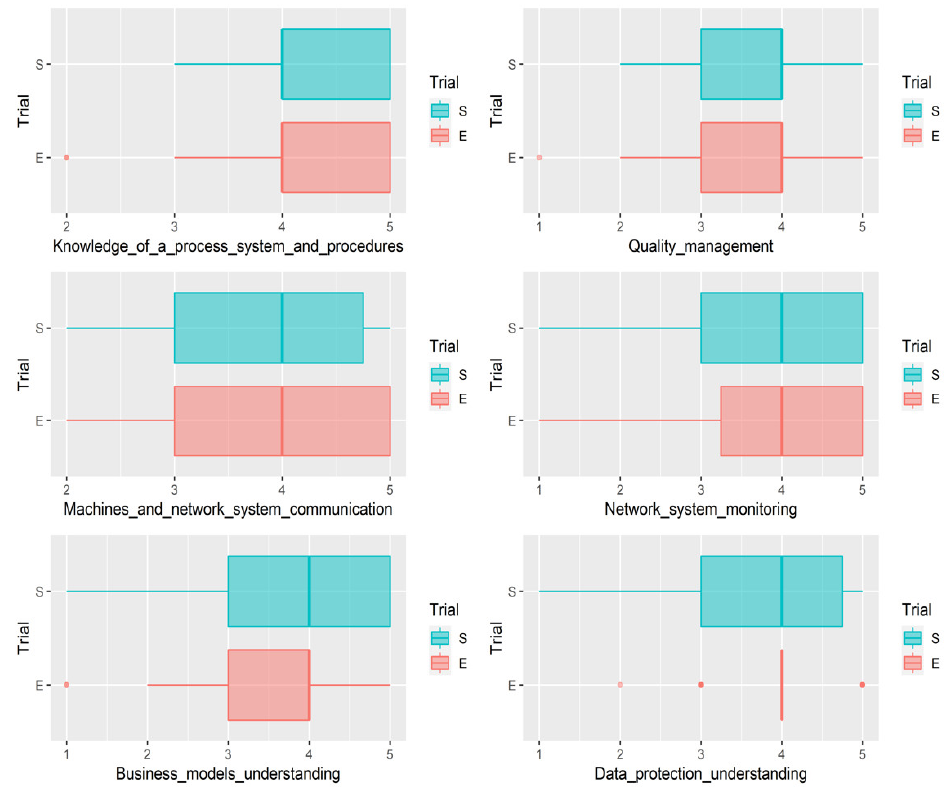
Figure 4. Assessments of technical competencies in the trials (1—not important, 5—very important). Source: own elaboration.